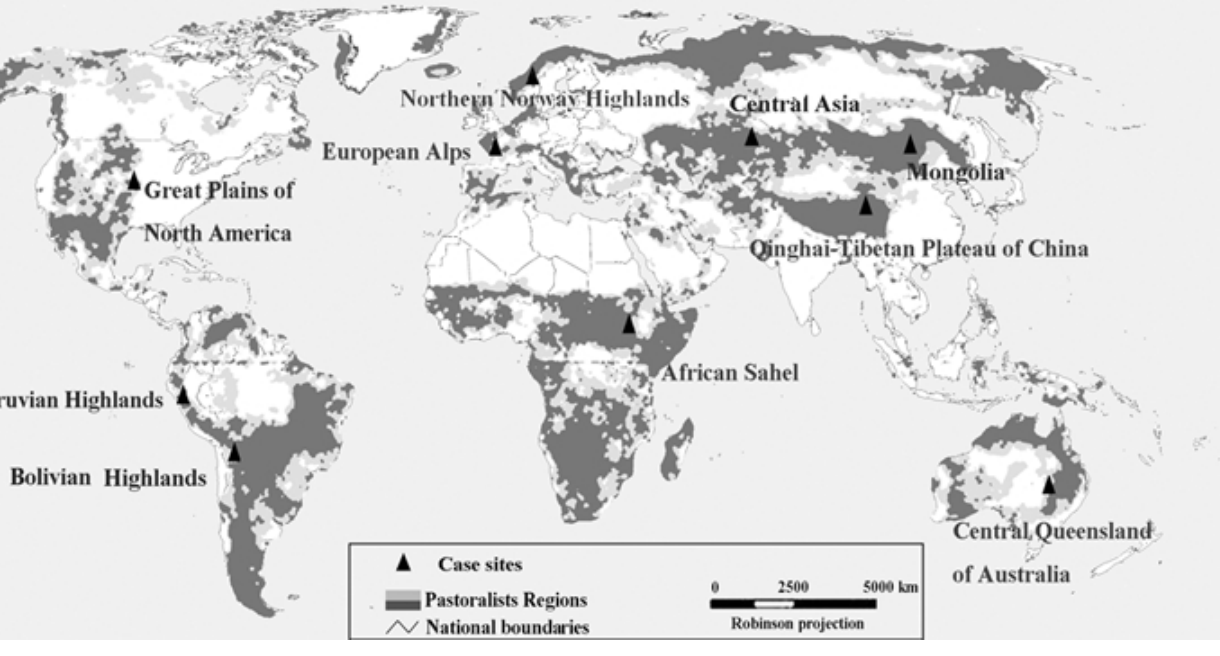
Fig. 2. Map of global pastoralism and case sites (modified from Nori and Davies